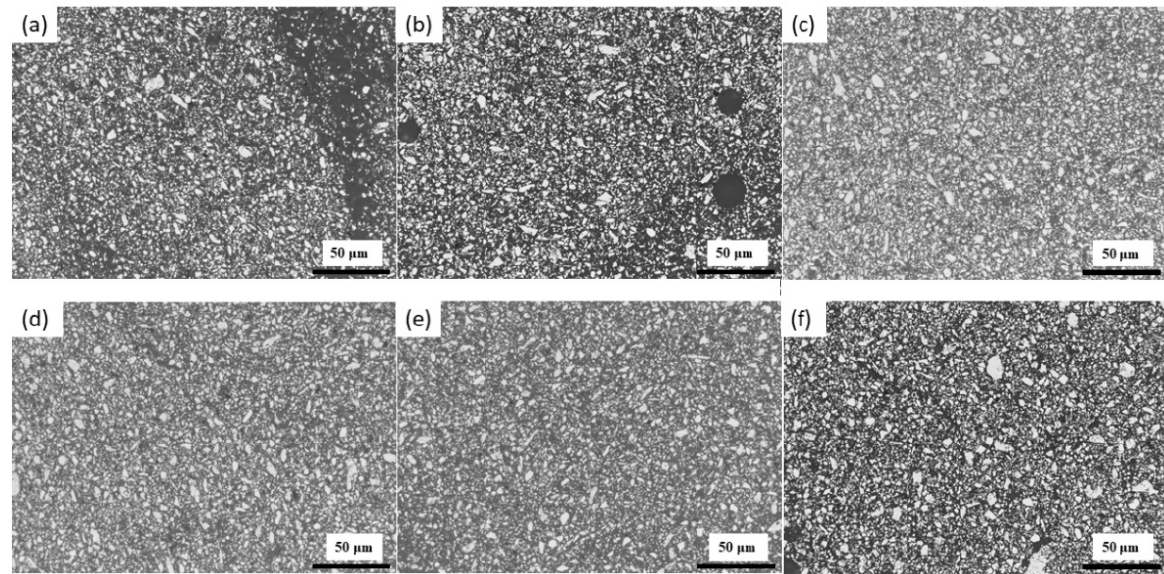
Table 1. Composition and Curie temperature for the investigated magnetocaloric powders P-1 AR–